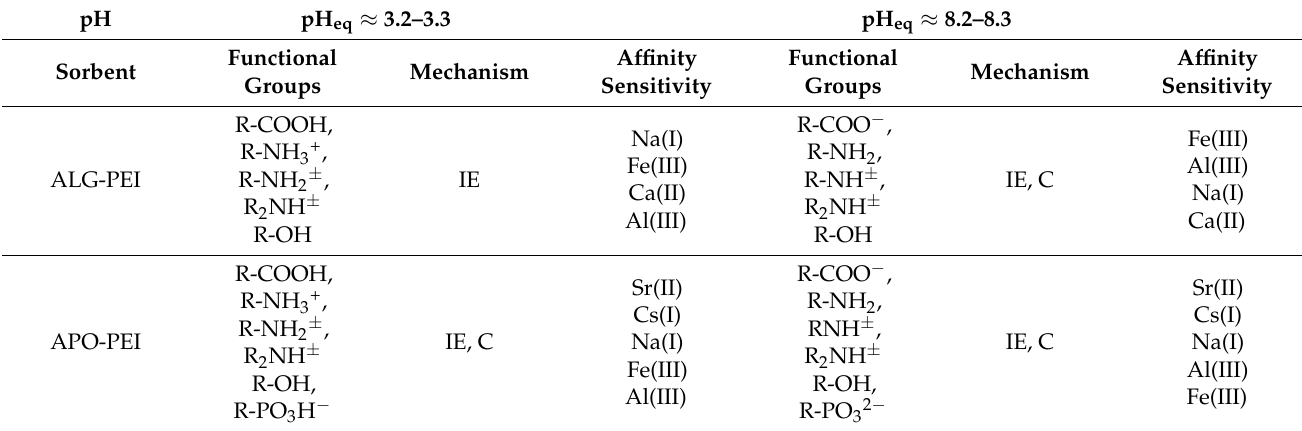
Figure A17. Sorption capacity (proportionality given by the size of the bubble) vs. the positioning of individual metals in the covalent index/ionic index space (data collected from [1,63,100]). Table A7. Summary of main conclusions on selectivity issues. Table A7. Summary of main conclusions on selectivity issues.